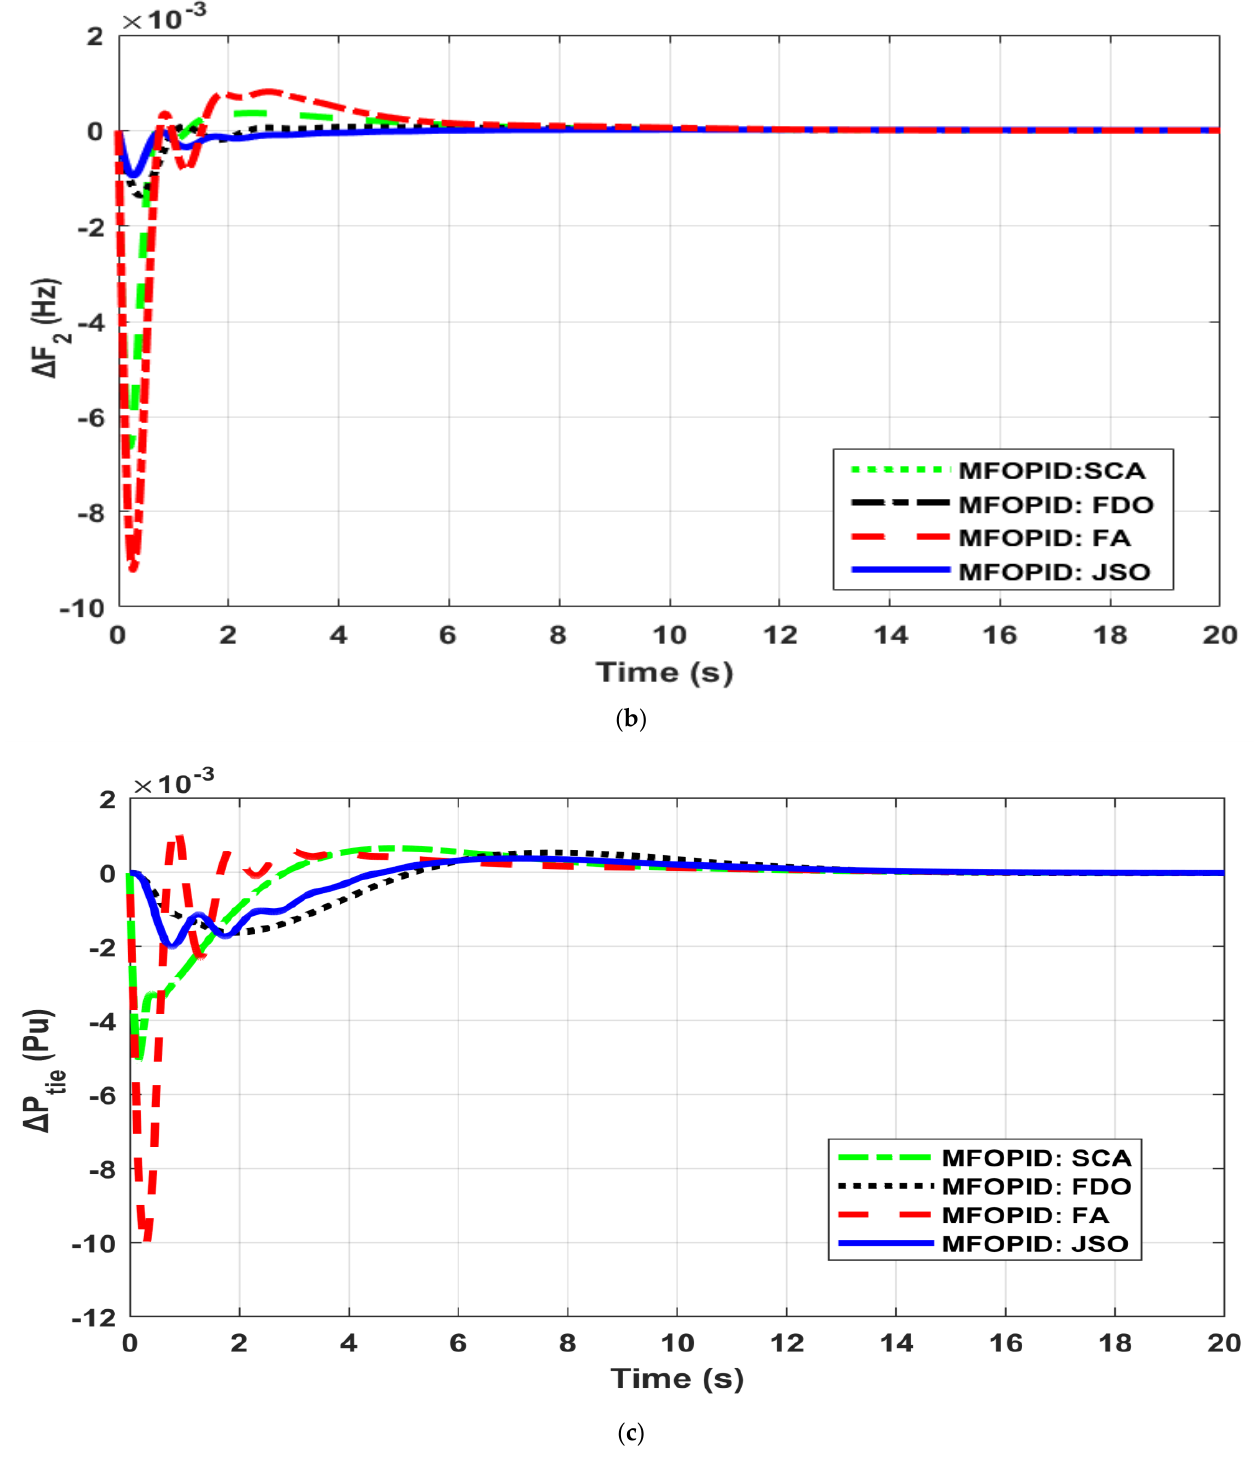
Figure 8. Output response of the PS considering case −1 for ( a ) ∆ F 1 ; ( b ) ∆ F 2 ; ( c ) ∆ P ite .